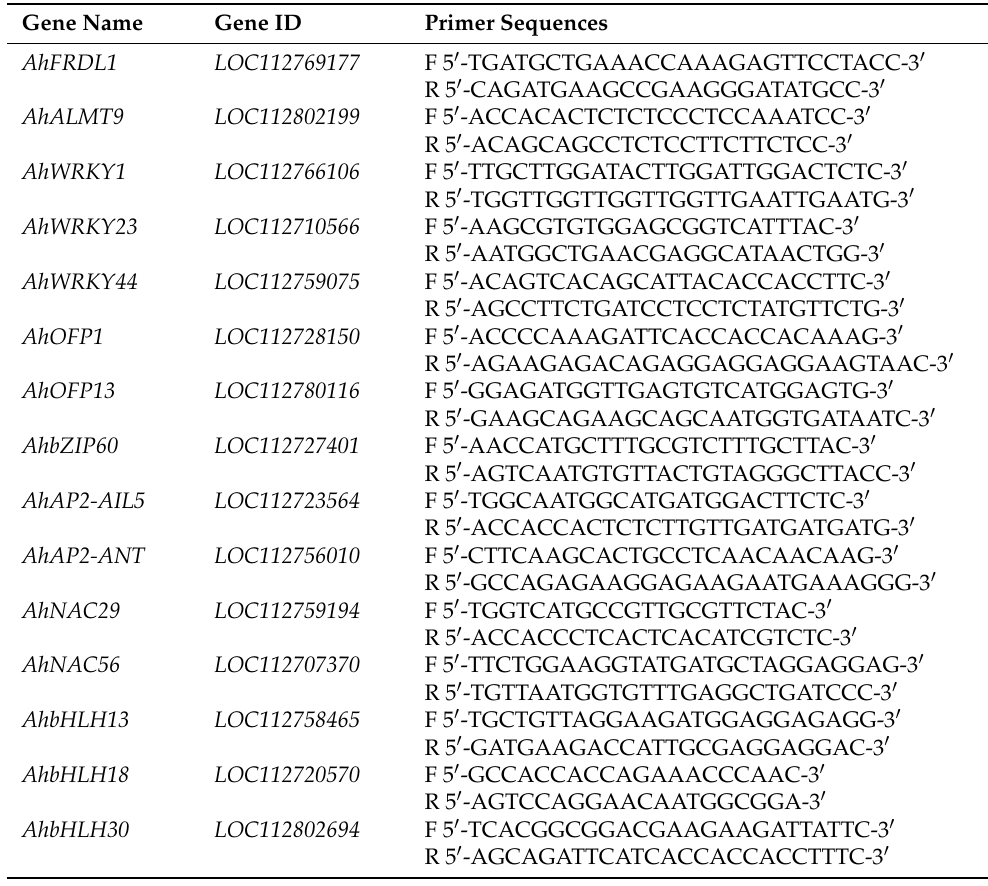
Table 1. Primer sequences of